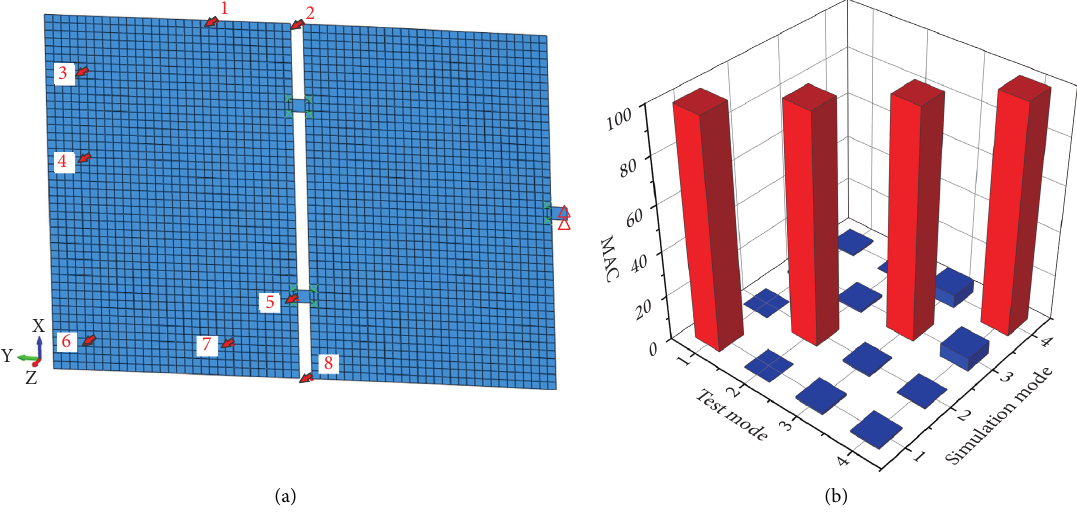
Figure 10: Optimal sensor placement: (a) sensor placement; (b) MAC